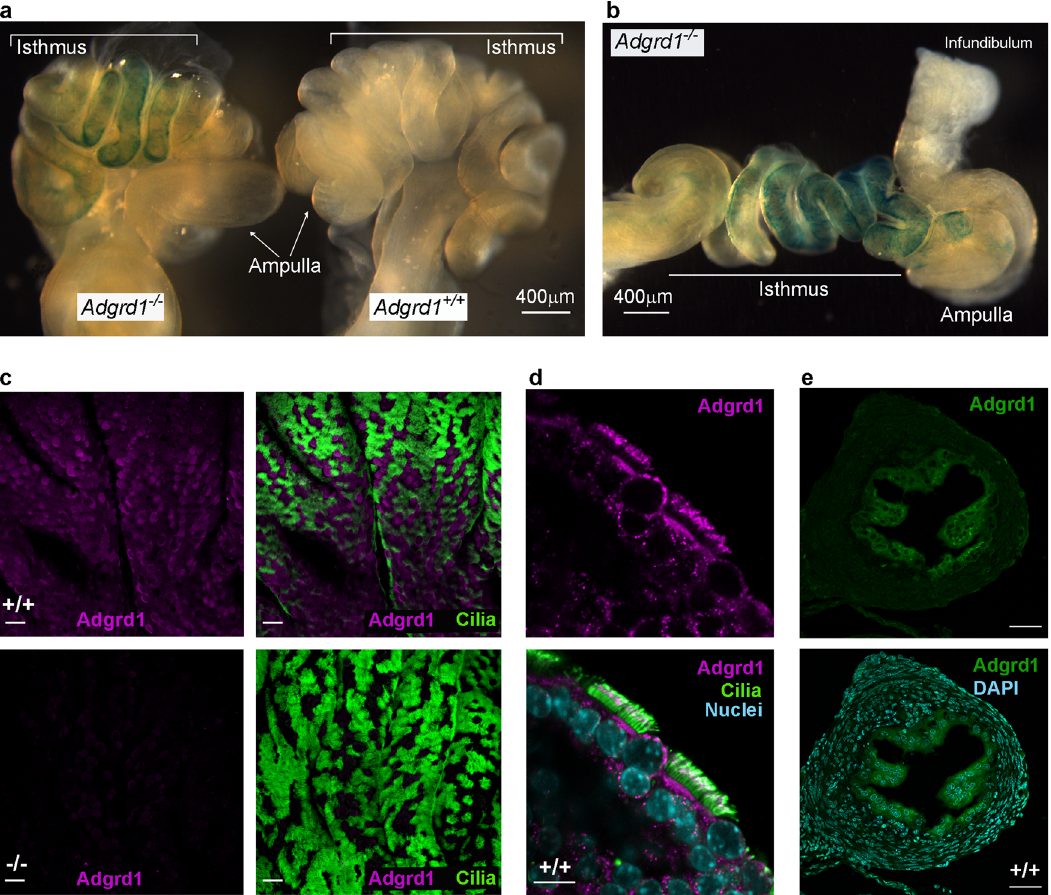
Fig. 2 Adgrd1 is expressed on the plasma membrane of both secretory and ciliated cells in the epithelium of the oviduct. a Adgrd1 promoter is active in the isthmus of the oviduct as detected by whole mount X-gal staining using the lacZ reporter enzyme. Staining is detected in the homozygous oviducts (left) but not in the wild-type sibling control (right). b Whole mount X-gal staining of homozygous Adgrd1 oviducts that have been removed from the ovary and uterus and partially extended to show Adgrd1 promoter activity in the isthmus. c An Adgrd1 polyclonal antibody raised against the entire ectodomain speci fi cally stains the ampullary epithelium (purple) from wild type (upper panels) but not Adgrd 1-de fi cient mice lower panels); anti-acetylated tubulin staining was used to mark ciliated cells (green). d Adgrd1 is localised on the apical plasma membrane of ciliated and non-ciliated cells in the oviductal epithelium. Scale bar represents 10 μ m. e , Expression of Adgrd1 in the epithelial cells of the isthmus is (green, upper panel) and nuclei counterstained with DAPI (blue, lower panel). c and e scale bars represent 50 μ m. Representative examples of three independent experiments are